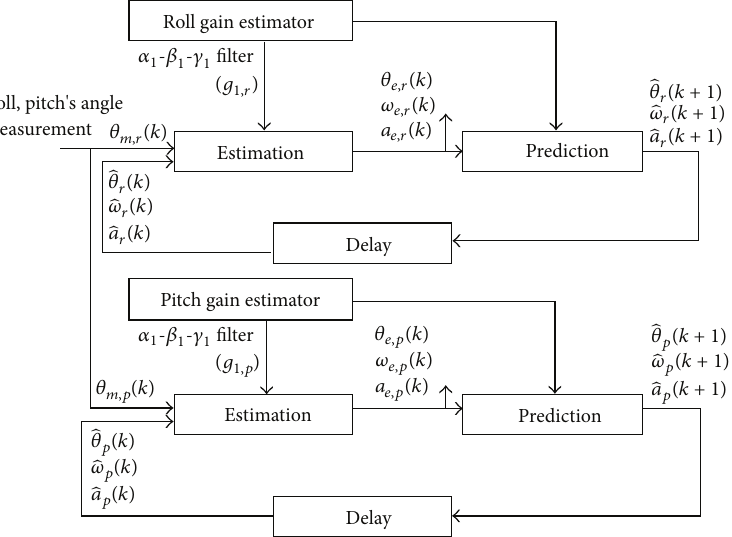
Figure 2: Parallel adaptive 𝛼 - 𝛽 - 𝛾 filter for beam pointing error